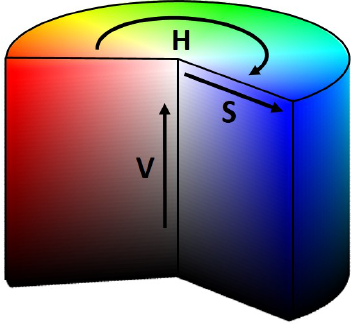
Figure 4. Cylindrical HSV color